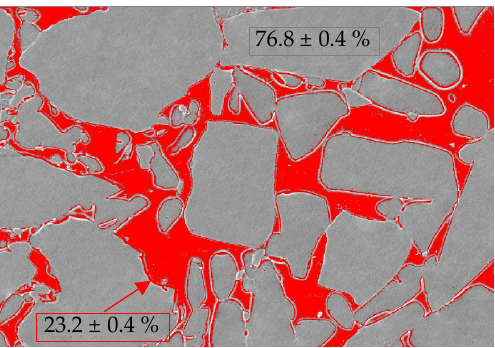
23.2 ± 0.4 % Figure 2. Image processing analysis obtained from IMAGE-J to quantify the area of each phase (in red the polymer area and in grey the ceramic area) for VE.